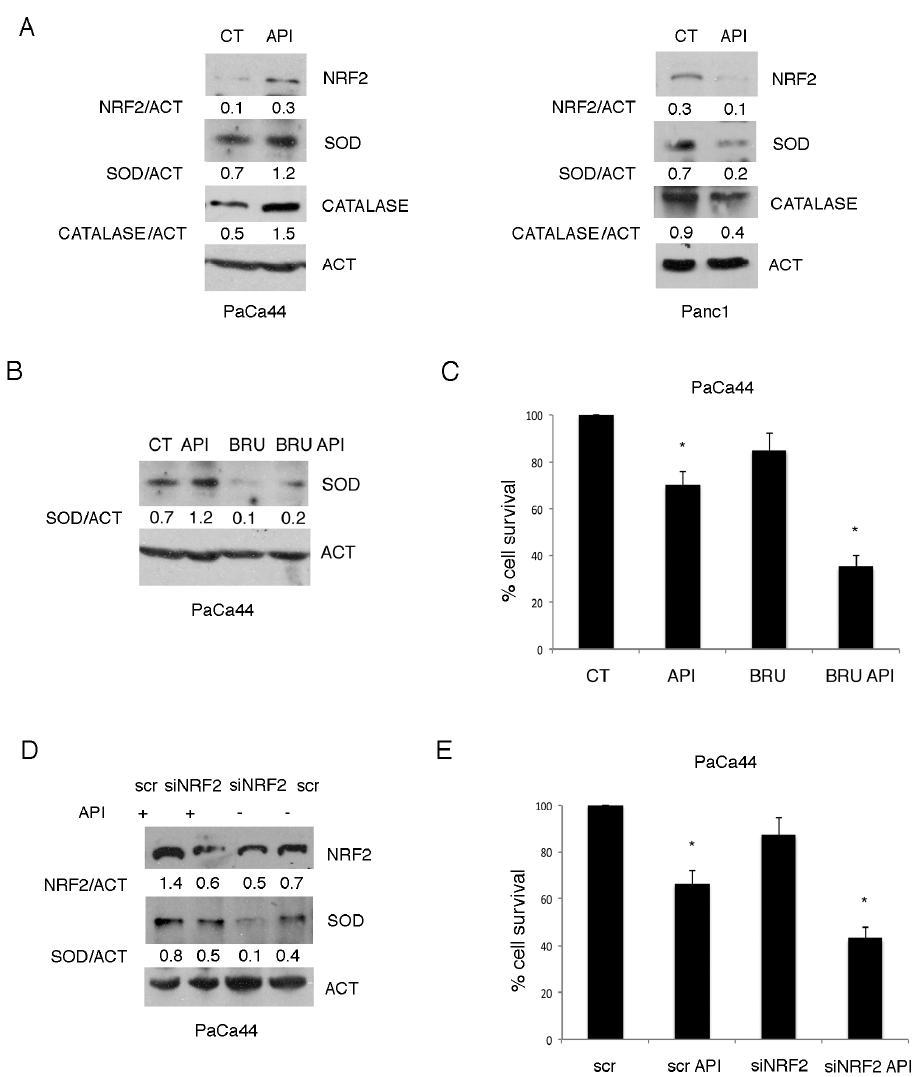
Figure 2. Induction of NRF2 correlates with chemoresistance to Apigenin. ( A ) NRF2, SOD, and catalase expression in Apigenin-treated or untreated PaCa44 and Panc1 cells evaluated by western blot analysis. Actin was used as loading control. A representative experiment out of three is shown and the densitometric analysis of the ratio of specific proteins / actin is reported; ( B ) SOD expression in 12.5 µ M Apigenin or 30 nM Brusatol-treated or the combination of 30 nM Brusatol and 12.5 µ M Apigenin and untreated PaCa44 cells evaluated by western blot analysis. Actin was used as loading control. A representative experiment out of three is shown and the densitometric analysis of the ratio of SOD / actin is reported; ( C ) Viability of untreated and 12.5 µ M Apigenin or 30 nM